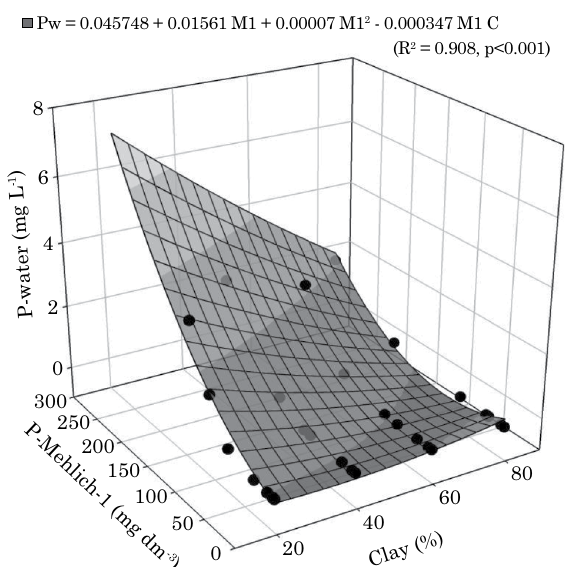
figure 3. Phosphorus-water (Pw) and P-mehlich-1 (m1) levels in soils with different clay percentages (C - 20, 40, 60, and 80 % clay) following incubation for 20 days with varying P rates.